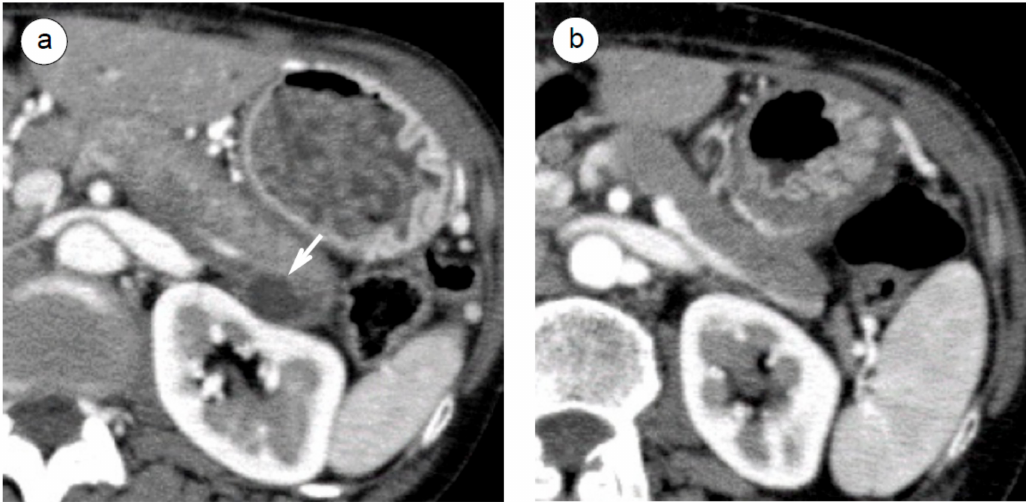
Figure4. AsteroidresponseinapancreaticcystofanAIPpatient. Computedtomographydemonstrated a unilocular cyst (arrow) at the pancreas tail, 15 mm in size, at the initial diagnosis of AIP ( a ). The cyst disappeared after steroid initiation ( b